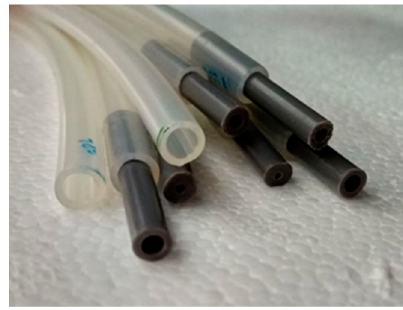
Figure 9. Small plastic reducers to simulate blockages.